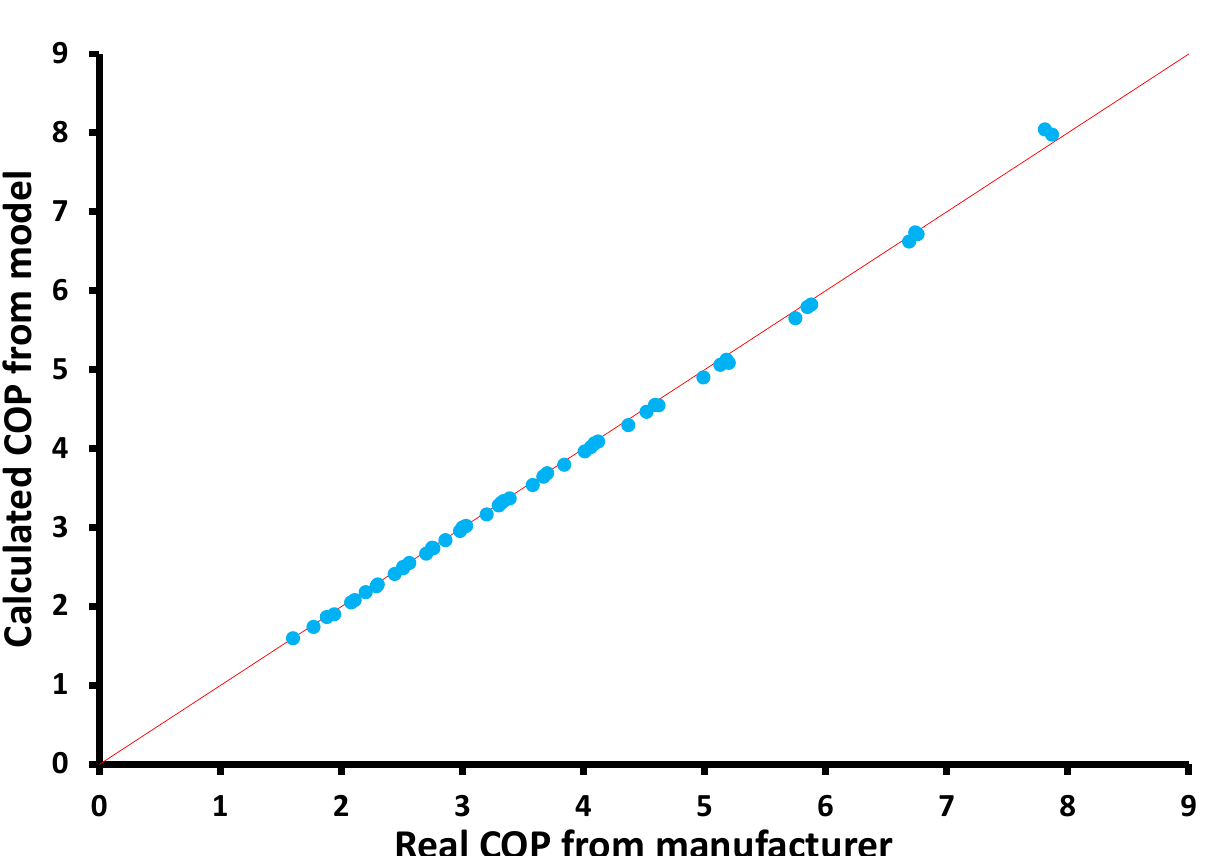
Figure 5. Variation in the compressor isentropic efficiency for different evaporator and condenser temperature levels.